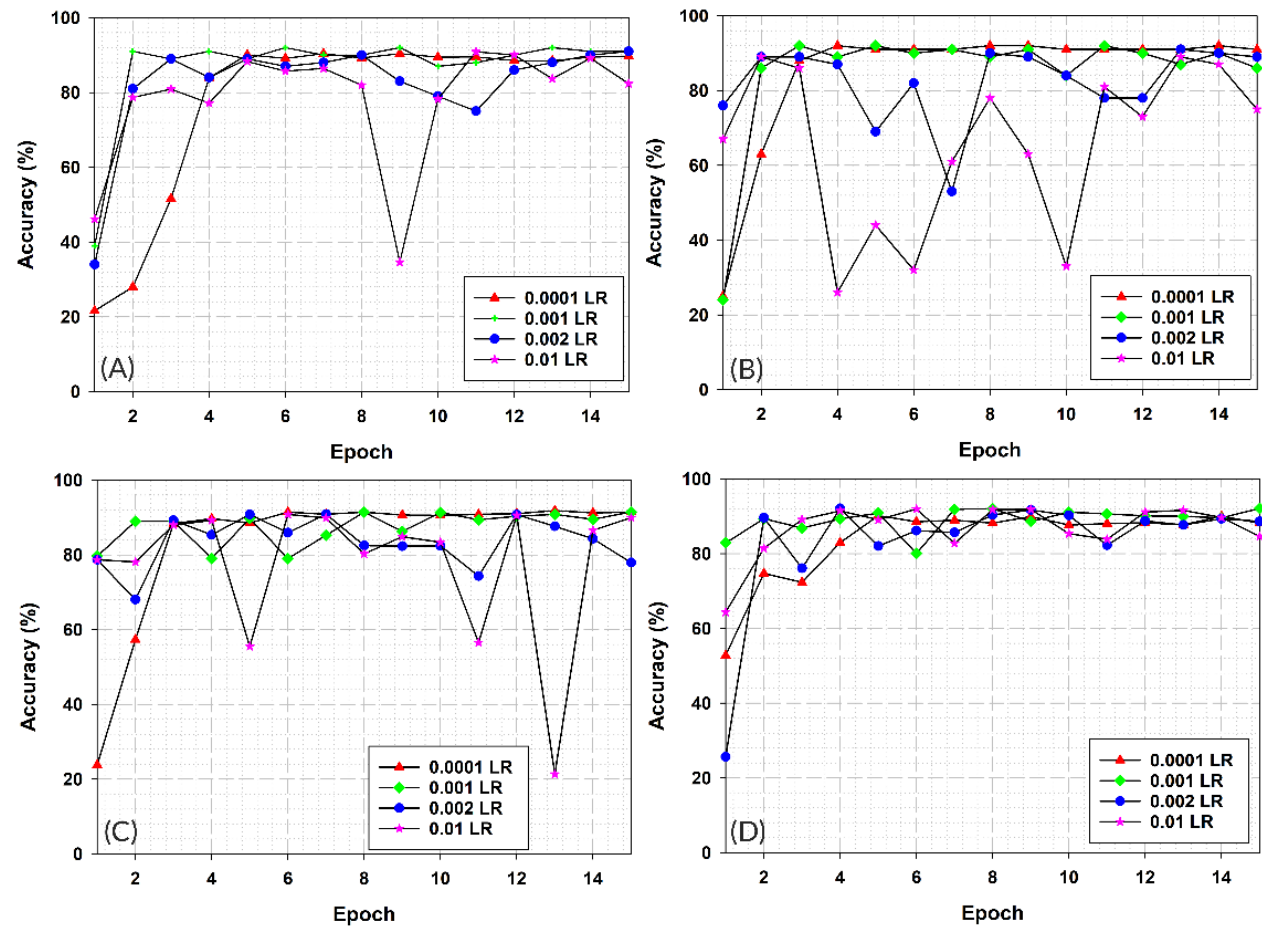
Figure 7. Training on deep residual networks with 18 layers using four different learning rates ( A ) non-pre-trained ResNet-18; ( B ) pre-trained ResNet-18; ( C ) non-pre-trained ResNet-34; ( D ) pre-trained ResNet-34.